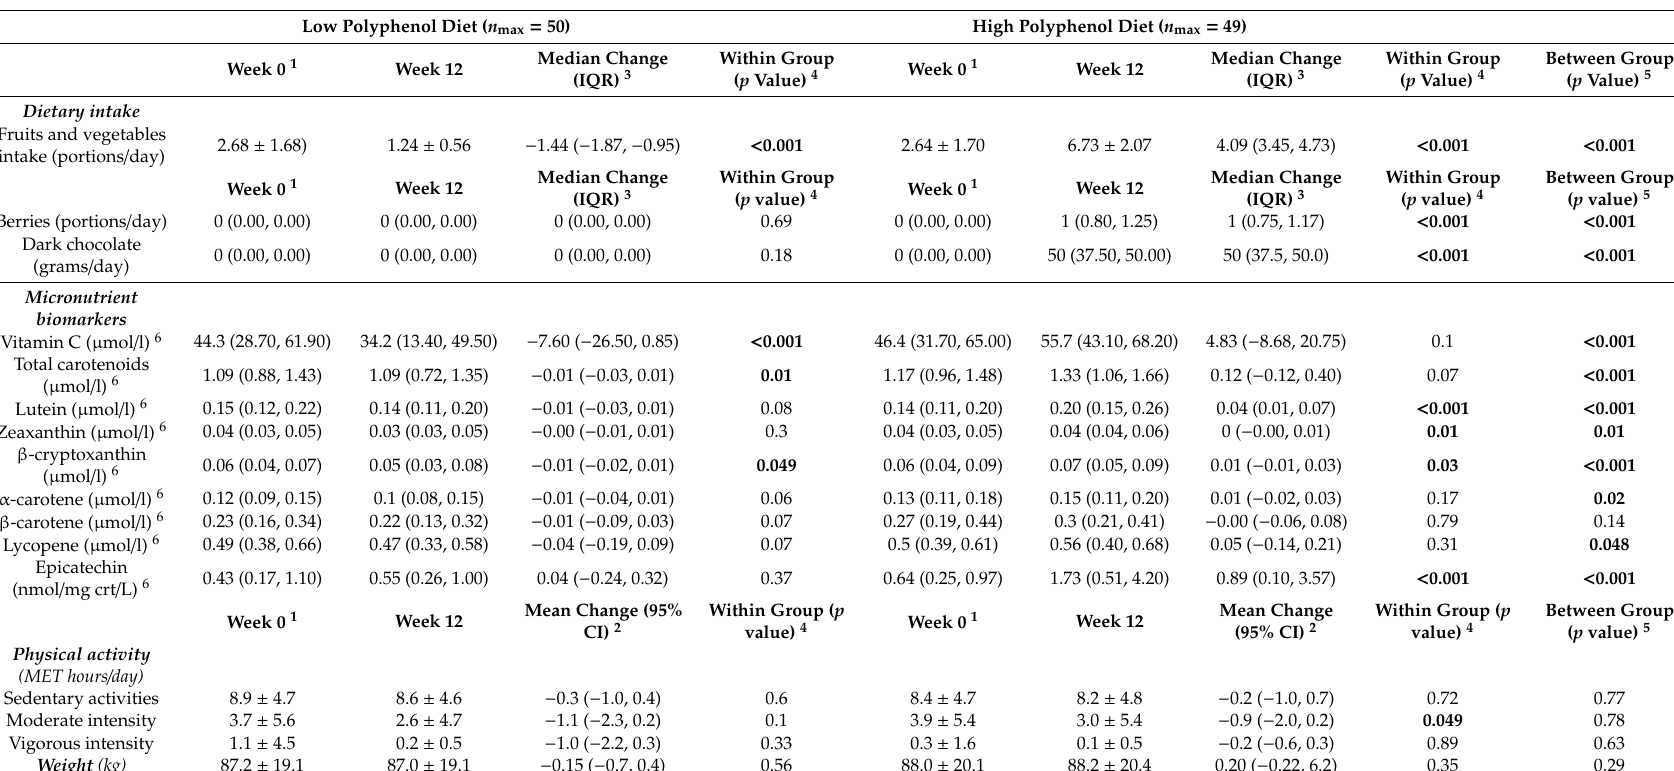
Table 2. Baseline (week 0) and end of intervention (week 12) dietary intake, plasma, serum and urine micronutrient biomarkers, physical activity and weight status characteristics according to the Polyphenol Intervention Trial (PPhIT) study group